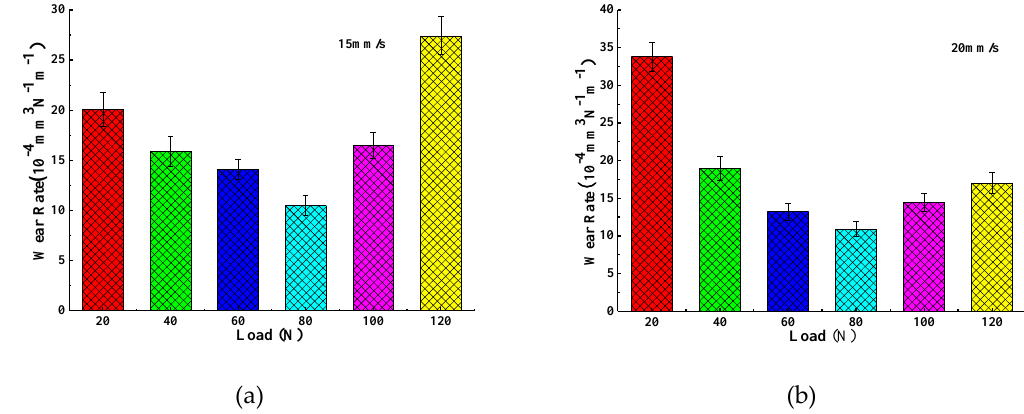
Figure 8. Wear rate histogram of sample oils under different loads. ( a ) sample oil #1; ( b ) sample oil #2.